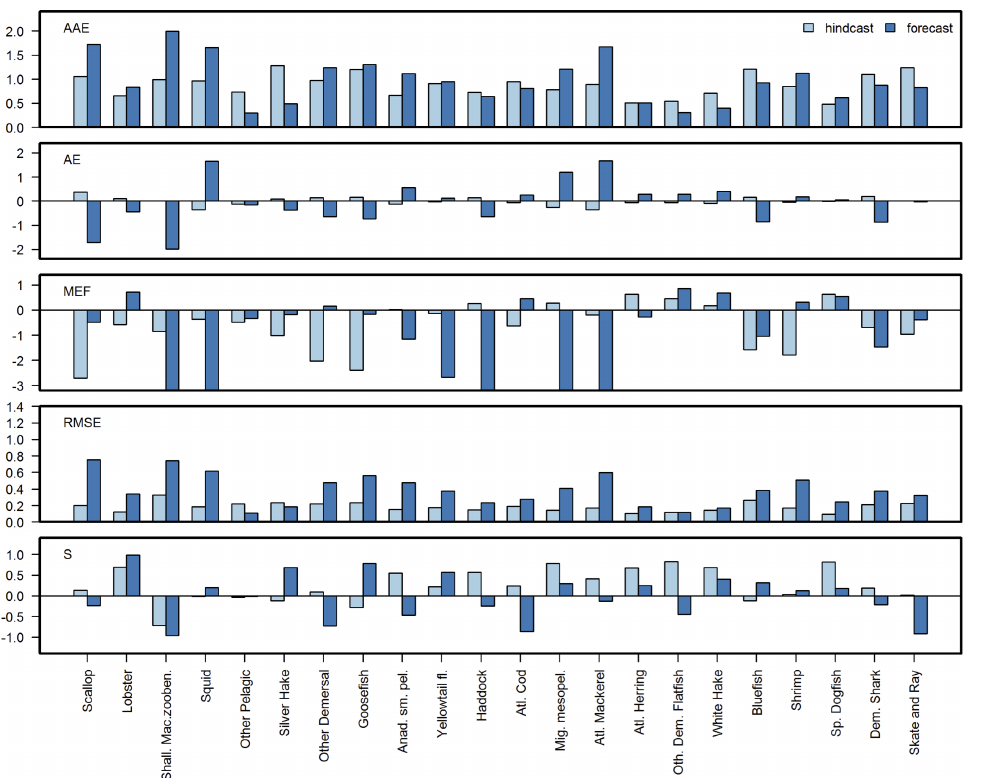
Fig 6. Forecast skill metrics for biomass data. Pairwise comparison of forecast and hindcast skill metric performance for 5 skill metrics: MEF, AE, AAE, RMSE and S(Spearman rank) Correlation for 22 species in the NEUS Atlantis ecosystem model. Y-axis limited to show values between -2 and